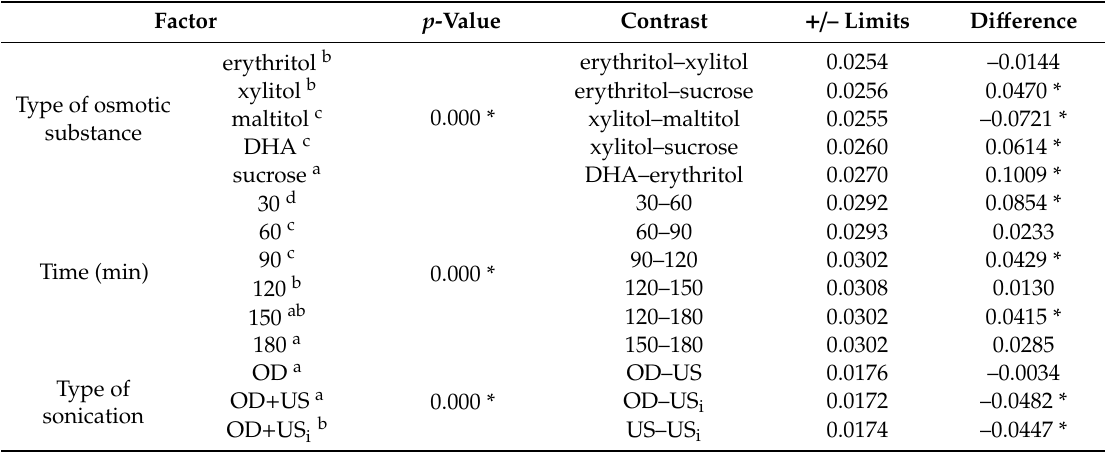
Table 9. The influence of osmotic agents and pre-treatment time on CR during OD.